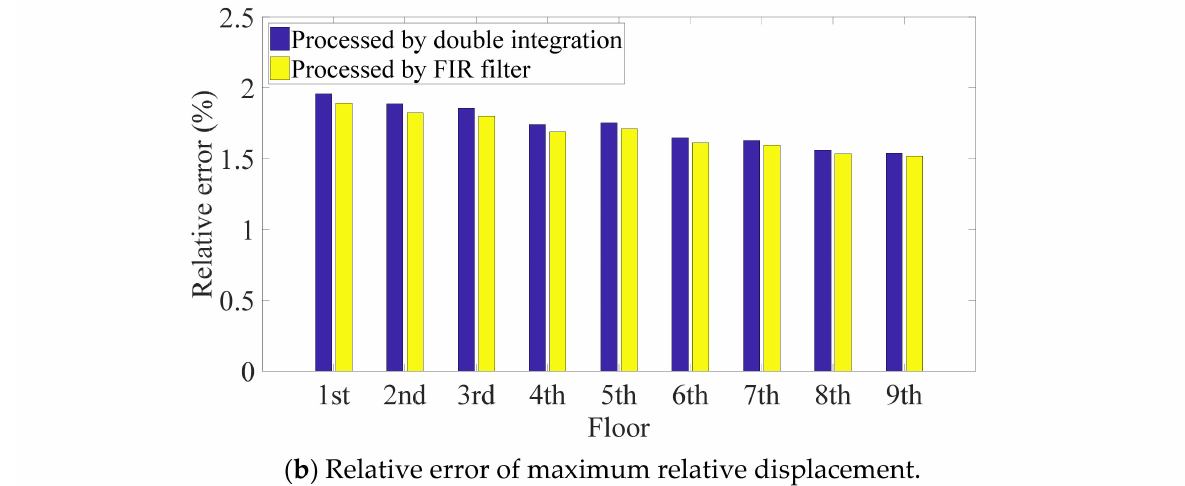
Figure 4. Estimated relative displacement of nine-DOF